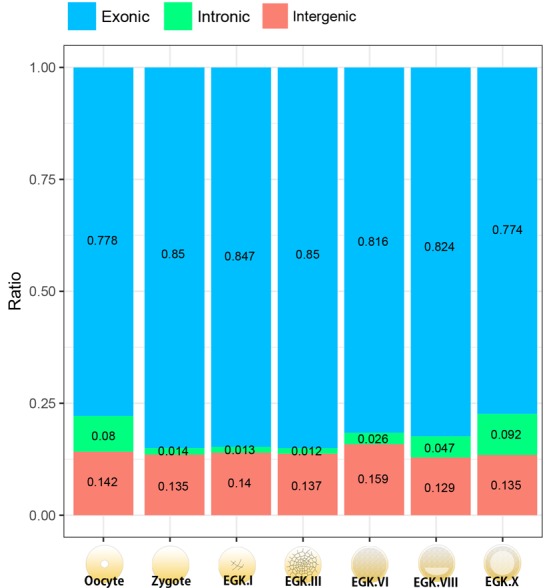
Distribution of mapped reads on the exonic, intronic and intergenic regions during chicken early development.The distribution of intronic reads is reduced after fertilisation and gradually increased after EGK.VI, probably because of the increase in the exonic proportion during both gene activation and processing of maternal RNAs. The proportion of intergenic regions exhibits little change during pre-ovipositional development in chicken.